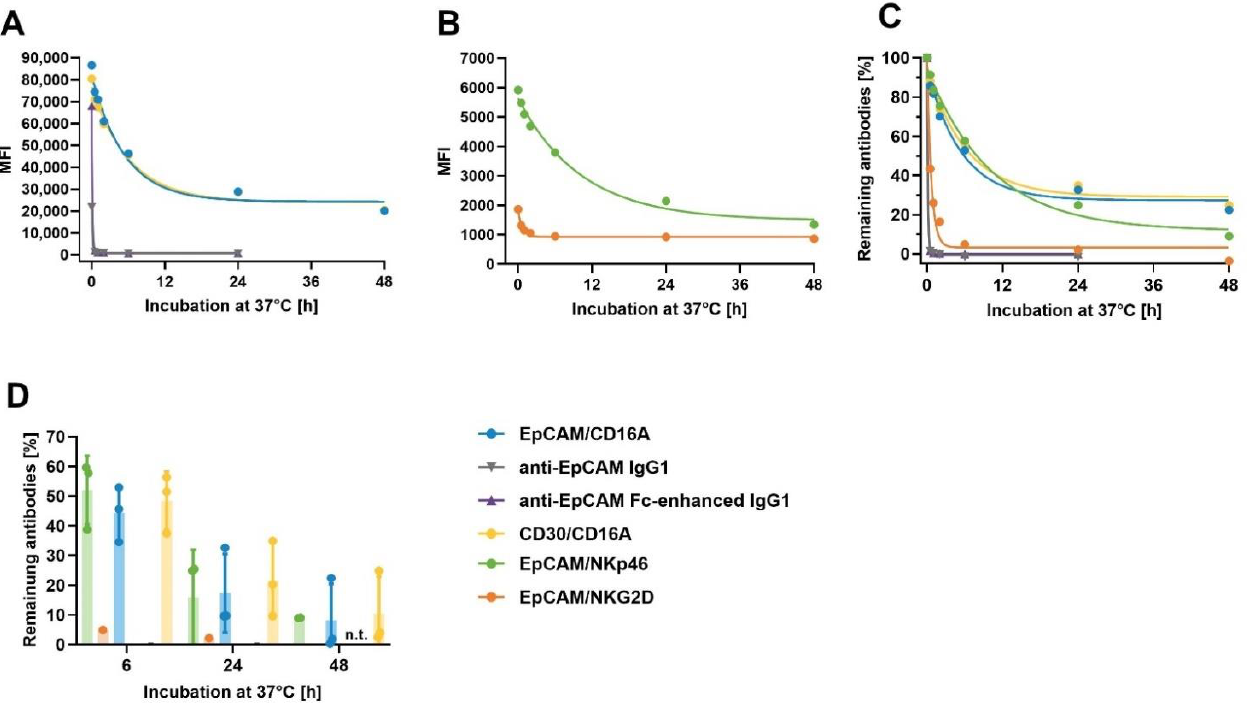
Figure 7. Retention of anti-EpCAM ICE ® and IgG1 antibodies on NK cells at 37 ◦ C. Aliquots of enriched primary human NK cells were pre-complexed with 100 µ g/mL of EpCAM/NKp46, EpCAM/NKG2D, EpCAM/CD16A, anti-EpCAM IgG1, anti-EpCAM Fc-enhanced IgG1, and CD30/CD16A as a control on ICE ® . After removal of unbound antibodies, aliquots were either directly stained with FITC-conjugated goat anti-human IgG1 Fc on ICE ® and analyzed by flow cytometry, or incubated for 0.5, 1, 2, 6, 24, and 48 h at 37 ◦ C before detection of retained antibodies by flow cytometry. After subtracting the MFI of NK cells incubated with the secondary reagent alone at the time point 0, MFI for retained EpCAM/CD16A ICE ® , anti-EpCAM IgG1, anti-EpCAM Fc-enhanced IgG1, and CD30/CD16A ICE ® ( A ), and EpCAM/NKp46 and EpCAM/NKG2D ICE ® constructs ( B ) were plotted. The percentage of retained ICE ® constructs and IgG1 antibodies relative to initially bound ICE ® constructs and IgG1 antibodies were plotted ( C ). One out of three representa- tive experiments is presented ( A – C ). The relative amount of retained antibodies after 6, 24, and 48 h incubations at 37 ◦ C determined in three independent experiments is shown in ( D ). The MFI for some samples were lower than MFI for staining with the secondary reagent alone, leading to negative values; values < − 10% were excluded. Where applicable, the individual and mean values ± standard deviation derived from three independent experiments are shown. FITC, fluorescein isothiocyanate; MFI, median fluorescence intensity; n.t., not